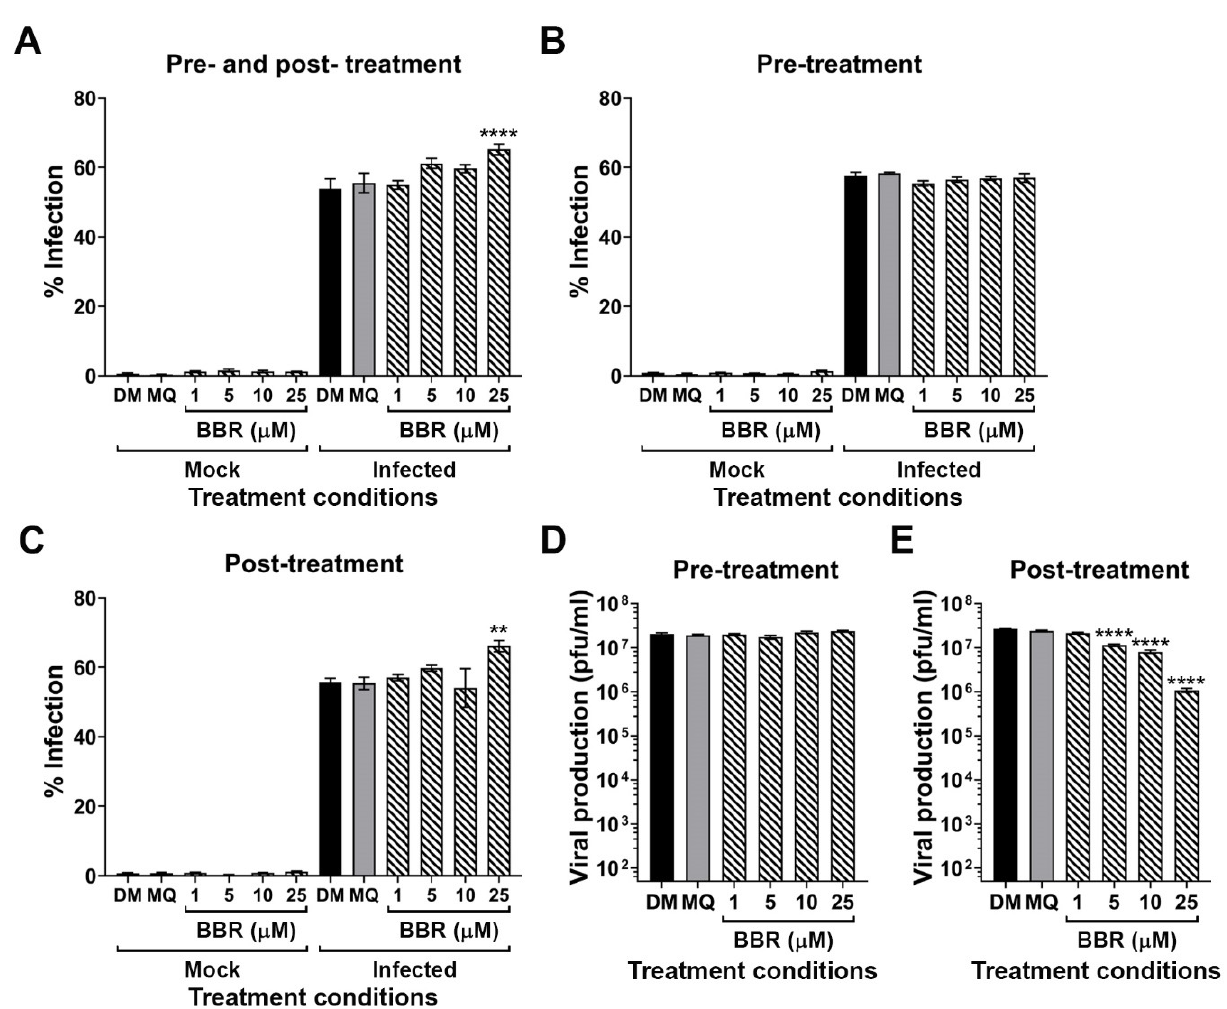
Figure 2. Effect of time of addition of BBR on DENV infection. BHK-21 cells were treated with an equivalent volume of DMEM (DM), milli-Q water (MQ) or 1–25 µM BBR before and/or after being mock infected or DENV 2 infected for 2 h follow by removal of media. Infected cells were further incubated for another 24 h with or without BBR as appropriate before collection of cells and supernatants. ( A – C ) Cells were analyzed for level of infection by flow cytometry. ( D , E ) DENV 2 titer was determined in the supernatant of experiments in which cells were infected. All experiments were undertaken independently in triplicate, with duplicate plaque assay. Error bars show ± S.E.M. ** p ≤ 0.01, **** p ≤ 0.0001.